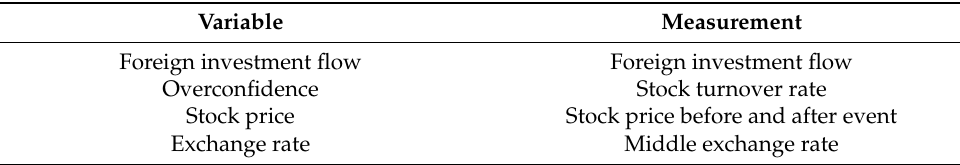
Table 2. Variable